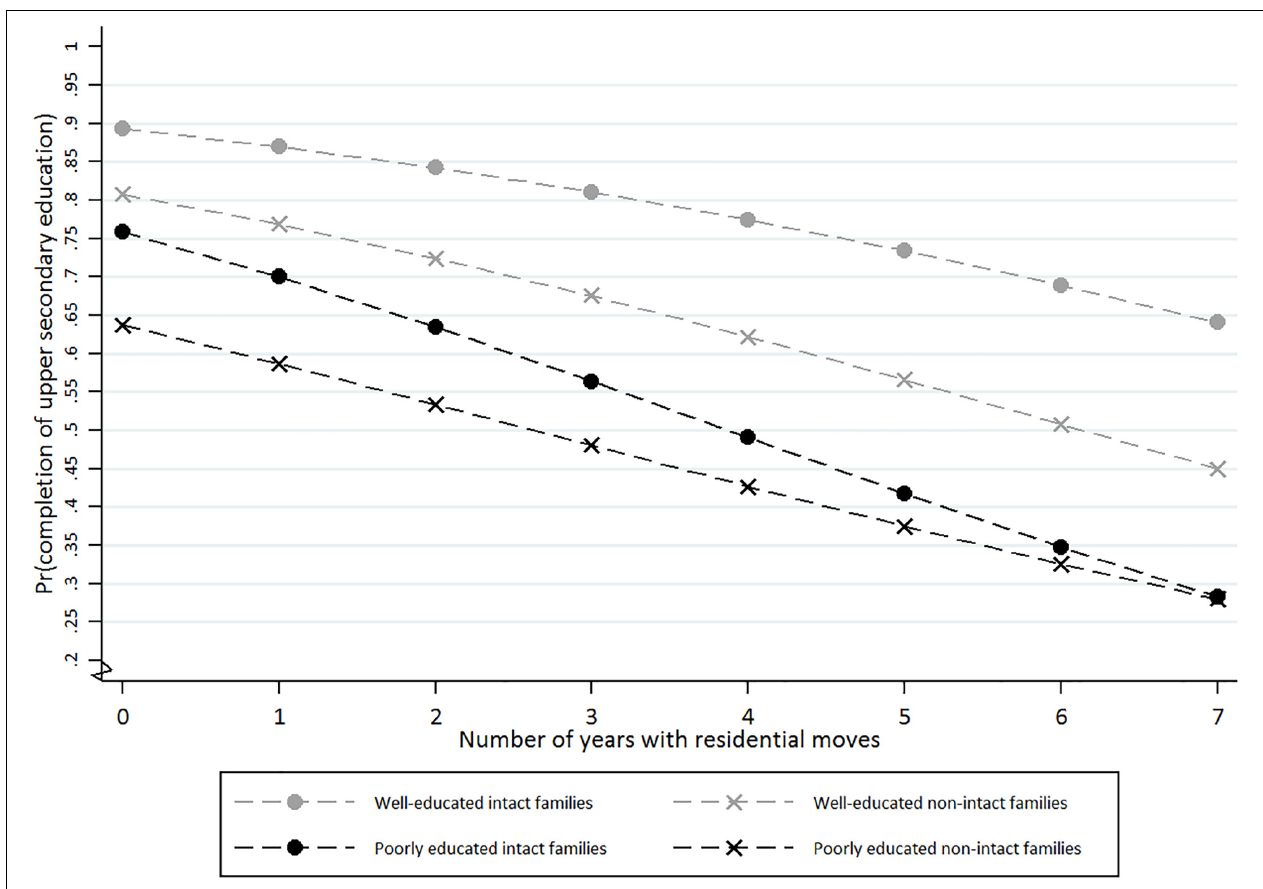
FIGURE 1 | Predicted probability (Pr) of upper secondary school completion by different types of family structures – divided into (i) “well-educated and intact,” (ii) “well-educated but non-intact,” (iii) “poorly educated but intact,” and (iv) “poorly educated and non-intact” – and number of years with residential moves during the follow-up period from 10 to 18 years